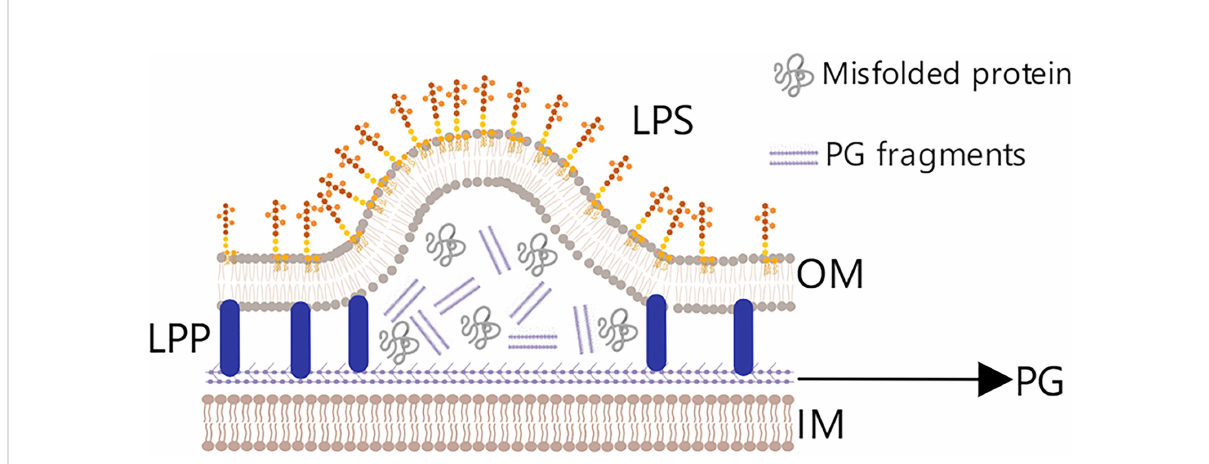
FIGURE 3 The pressure hypothesis. Peptidoglycan fragments and misfolded proteins are abundant in the periplasmic space of Gram-negative bacteria, and their aggregates put pressure on the outer membrane (OM), ultimately causing the OM and PG to separate and OMVs to be